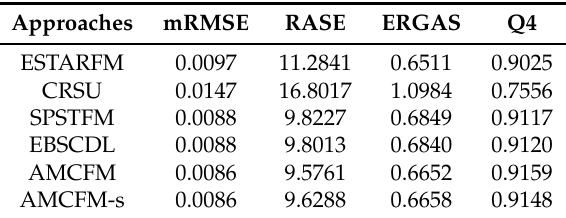
Table 8. Global quality metrics in image